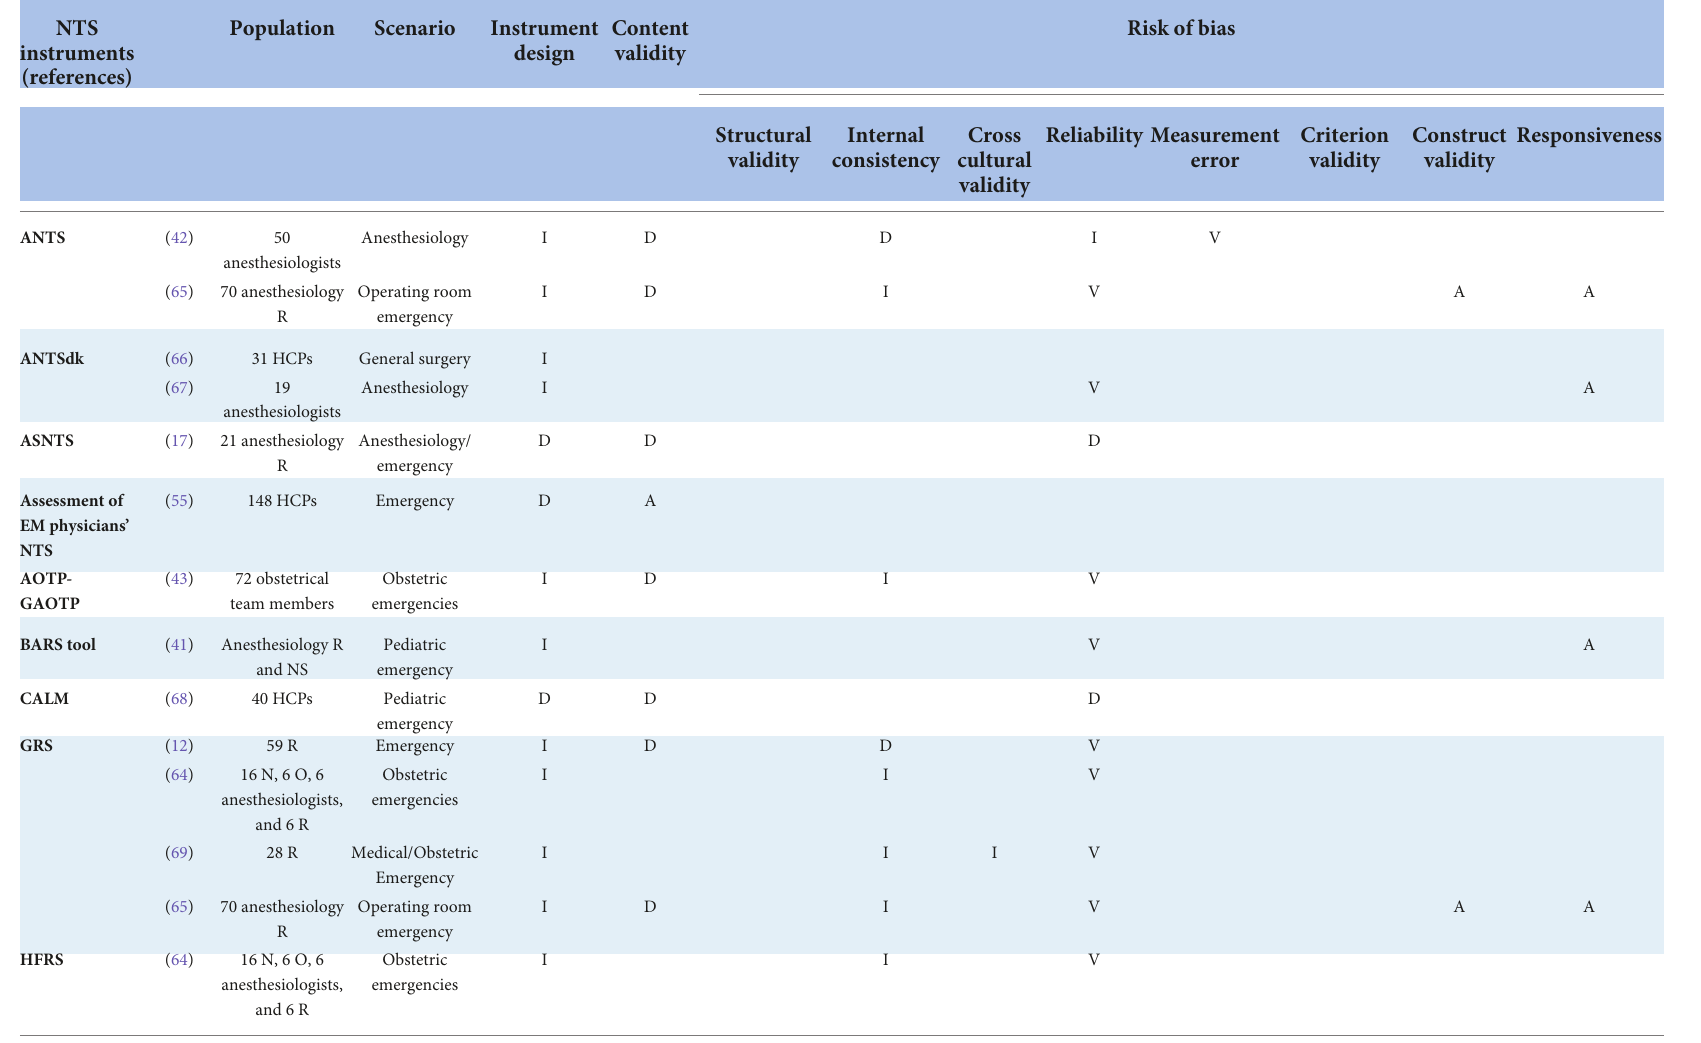
TABLE 2 Methodological quality of the included studies by measurement properties of NTS